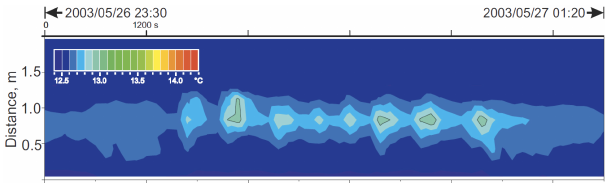
Figure 7. The temperatures in space–time domain during 110min of the A7a heating experiment where a long “train” of strong heat pulses is observed. The color-coding is the same as in Figs. 4 and